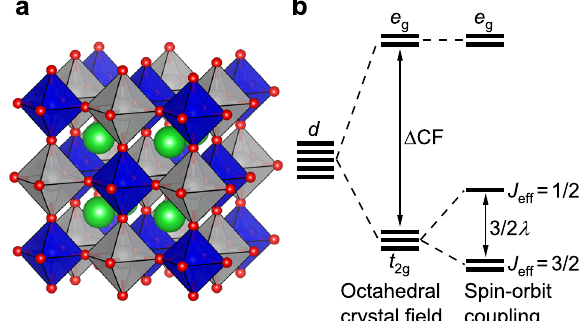
Fig. 1 Structure and orbital splitting. a The double perovskite structure of Ba 2 LuMoO 6 . Ba, Lu, Mo, and O are represented by the green, gray, blue, and red spheres, respectively. The magnetic Mo 5 + (4 d 1 ) cations in blue form an undistorted fcc lattice. b Scheme of the orbital splitting for a 4 d 1 or a 5 d 1 cation adapted from refs. 5,8 . The octahedral crystal fi eld splits the d orbitals into t 2g and e g states. The t 2g states have an effective orbital angular momentum L eff = 1. Spin- orbit coupling further splits the six-fold degenerate t 2g states into a J eff = 3/2 quartet ground state and a J eff = 1/2 doublet excited state. Note that for 4 d 5 and 5 d 5 cations the situation is reversed and J eff = 1/2 is the ground state while J eff = 3/2 is the excited state.